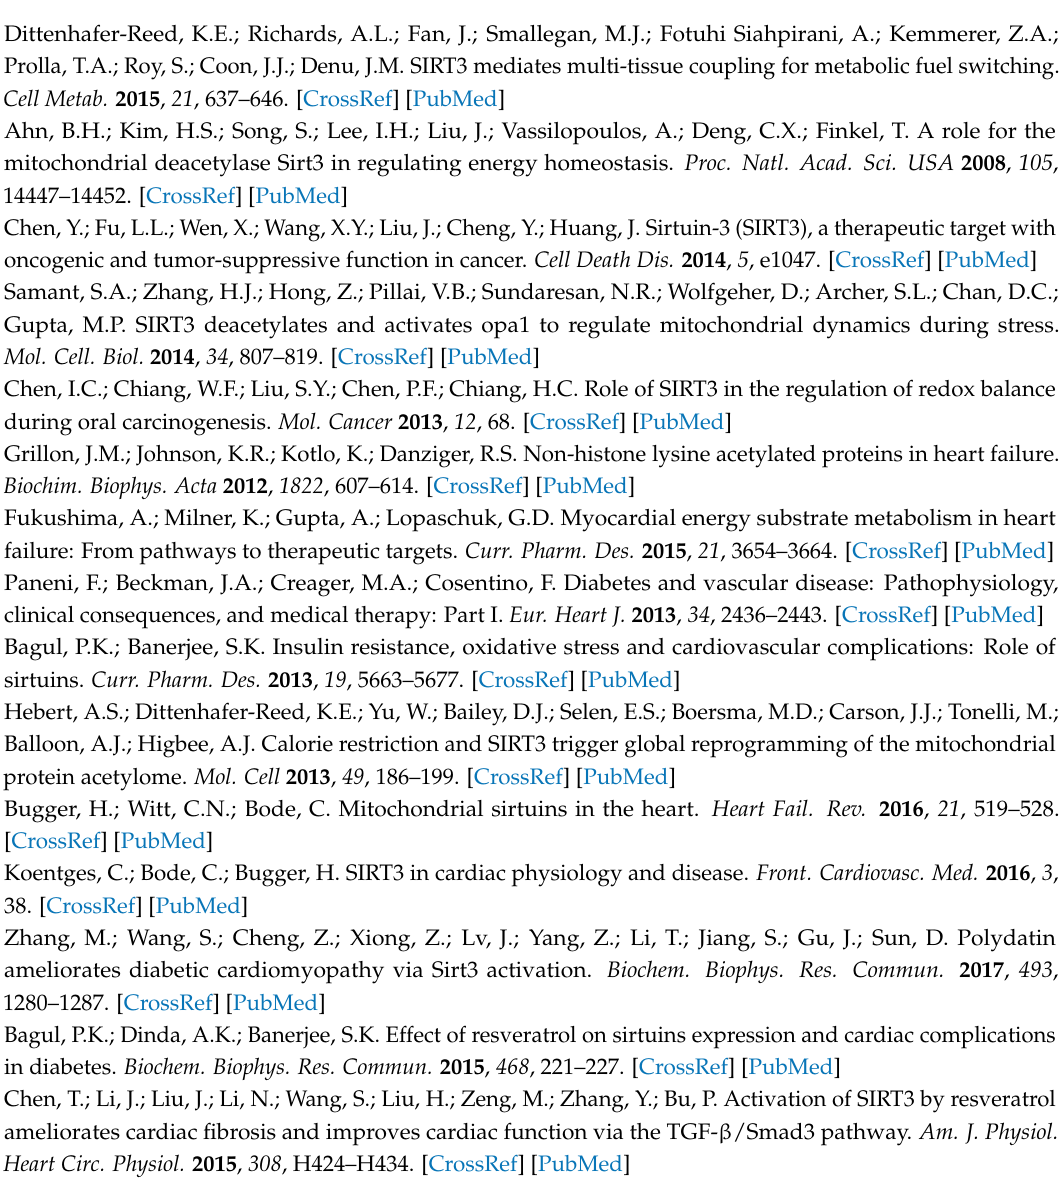
Figure S1: Effect of SIRT-3 overexpression and stable knockdown in H9c2